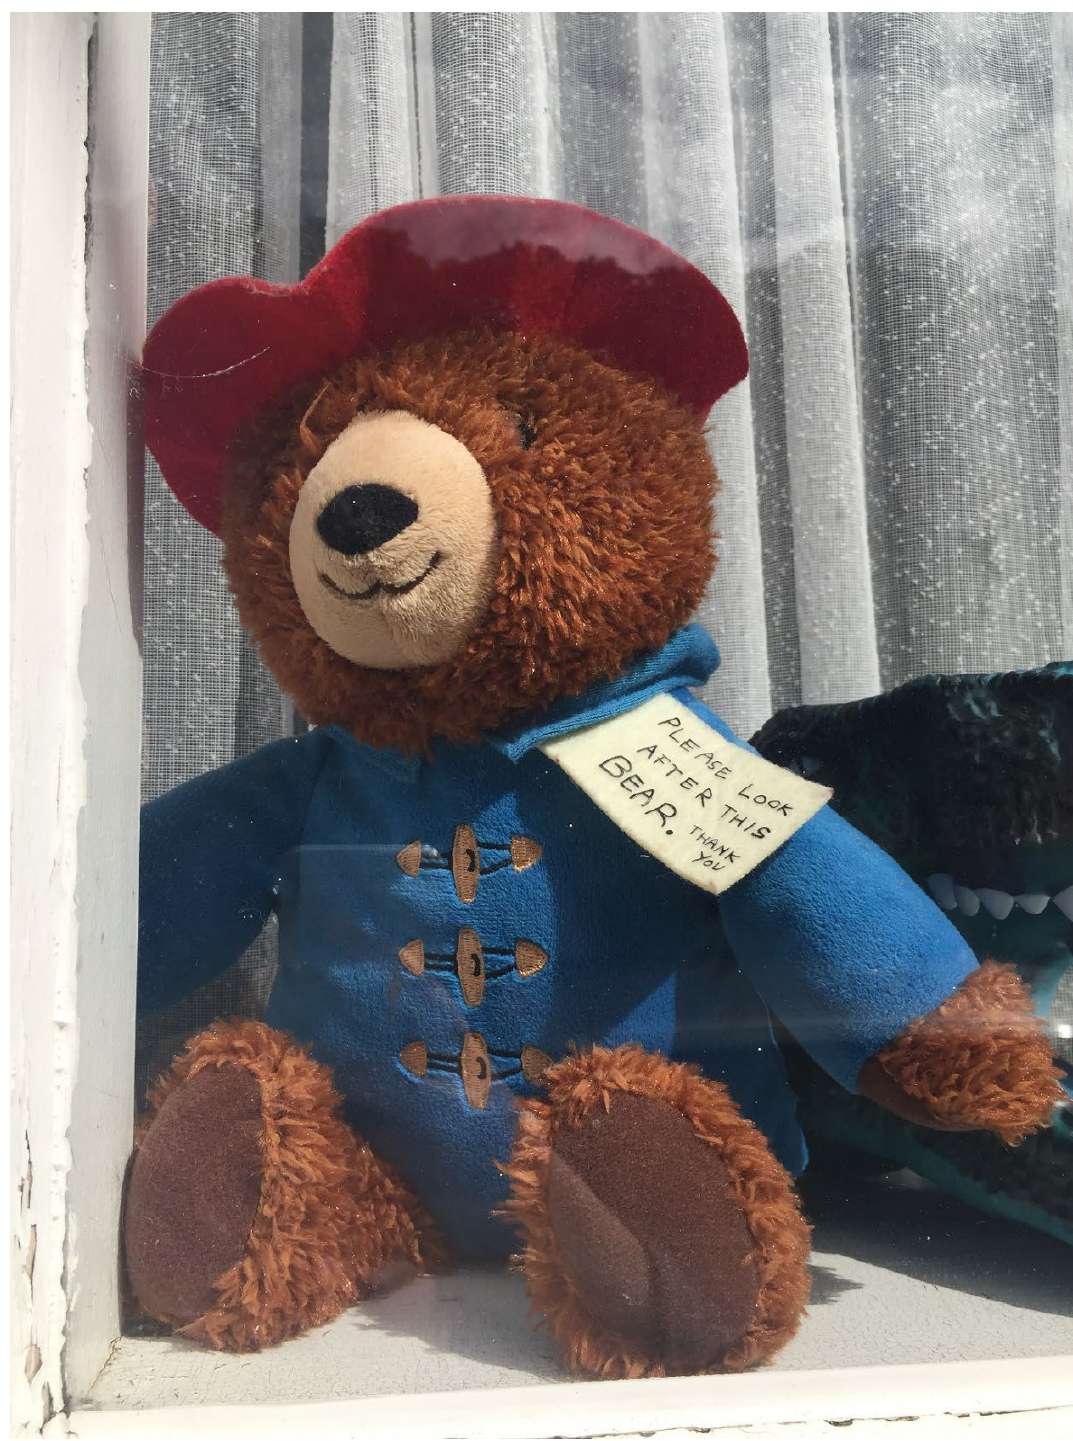
Figure 1. Paddington appearing as one of the many ‘teddy bears in windows’ on display. Image by Revena Correll Trnka. Reproduced with